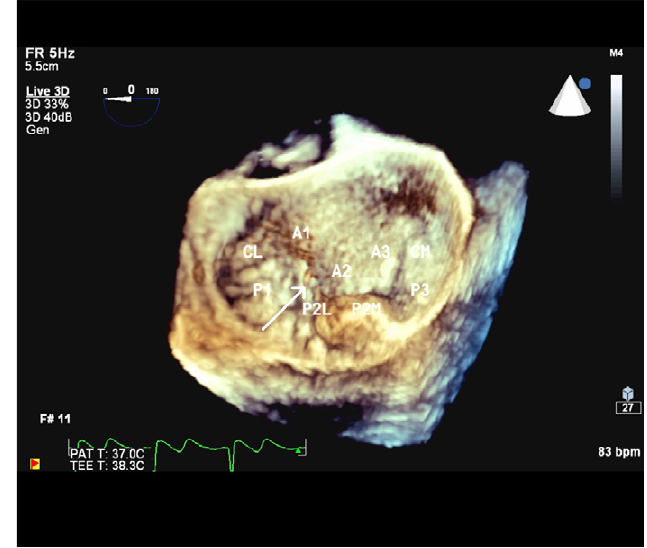
Figure. 4 Real-time 3D echocardiograph of the mitral valve showing ruptured chords at P2L (lateral segment of the middle scallop) pointed by arrow. In addition, P1 is abnormally large requiring height reduction.